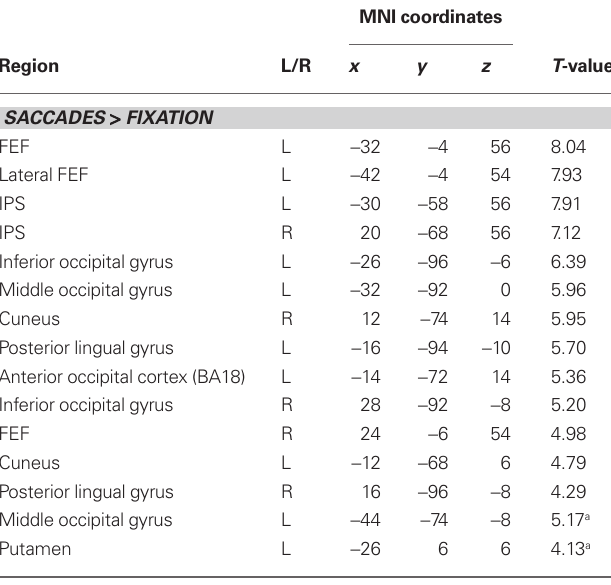
Table 1 | Activity clusters for all saccades vs. fixation (non-standard HRF). Table 2 | Activity clusters for all saccades vs. fixation (standard